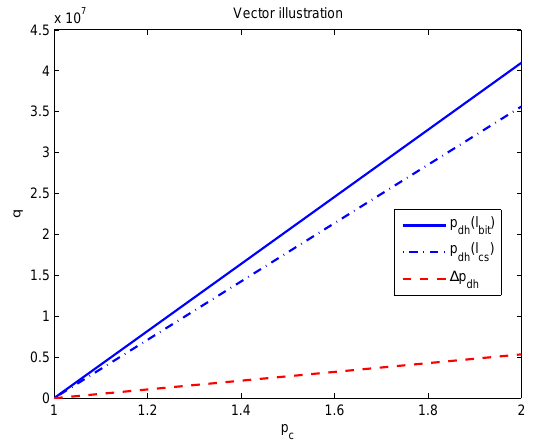
Figure 3: Vector illustration. The effect of flow q and choke pressure p c on the DHPs are similar, but the effect on the difference between them is more